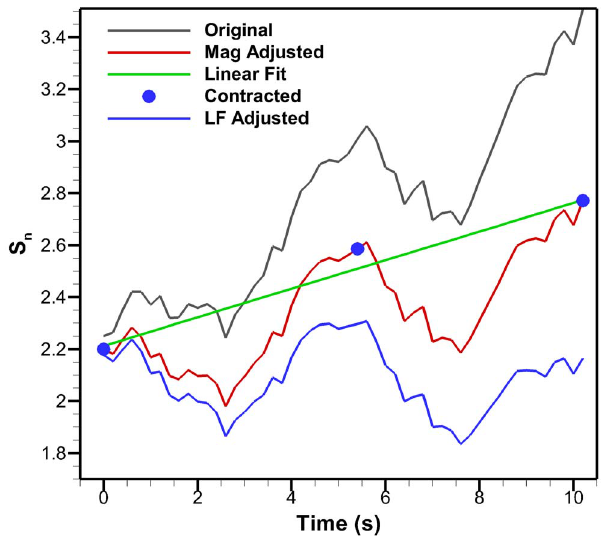
Fig. 6. Exumbrella arclength. Normalized exumbrella arclength as a function of time for two full swimming cycles starting fully contracted. The ‘‘Original’’ lengths correspond to the unprocessed profiles. The ‘‘Mag Adjusted’’ lengths are the ‘‘Original’’ lengths corrected for magnification based on the camera movement relative to the ocean floor. The ‘‘Linear Fit’’ is through the three fully ‘‘Contracted’’ instances. The ‘‘LF Adjusted’’ lengths are the ‘‘Mag Adjusted’’ lengths with the additional ‘‘Linear Fit’’ adjustment.